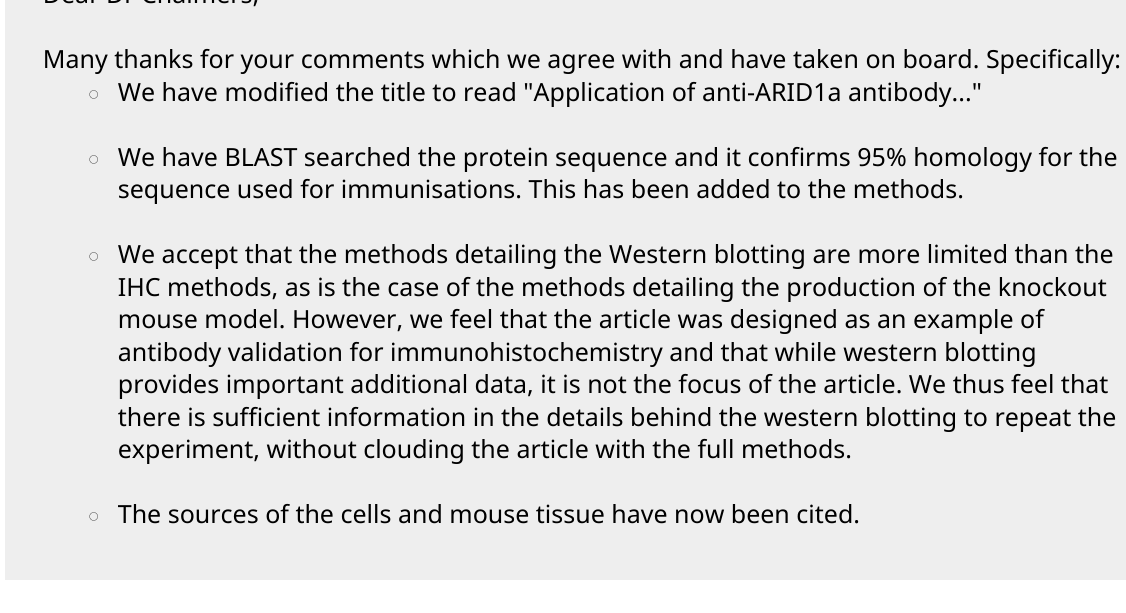
Figure 1 legend. Should read “represents the loading control”